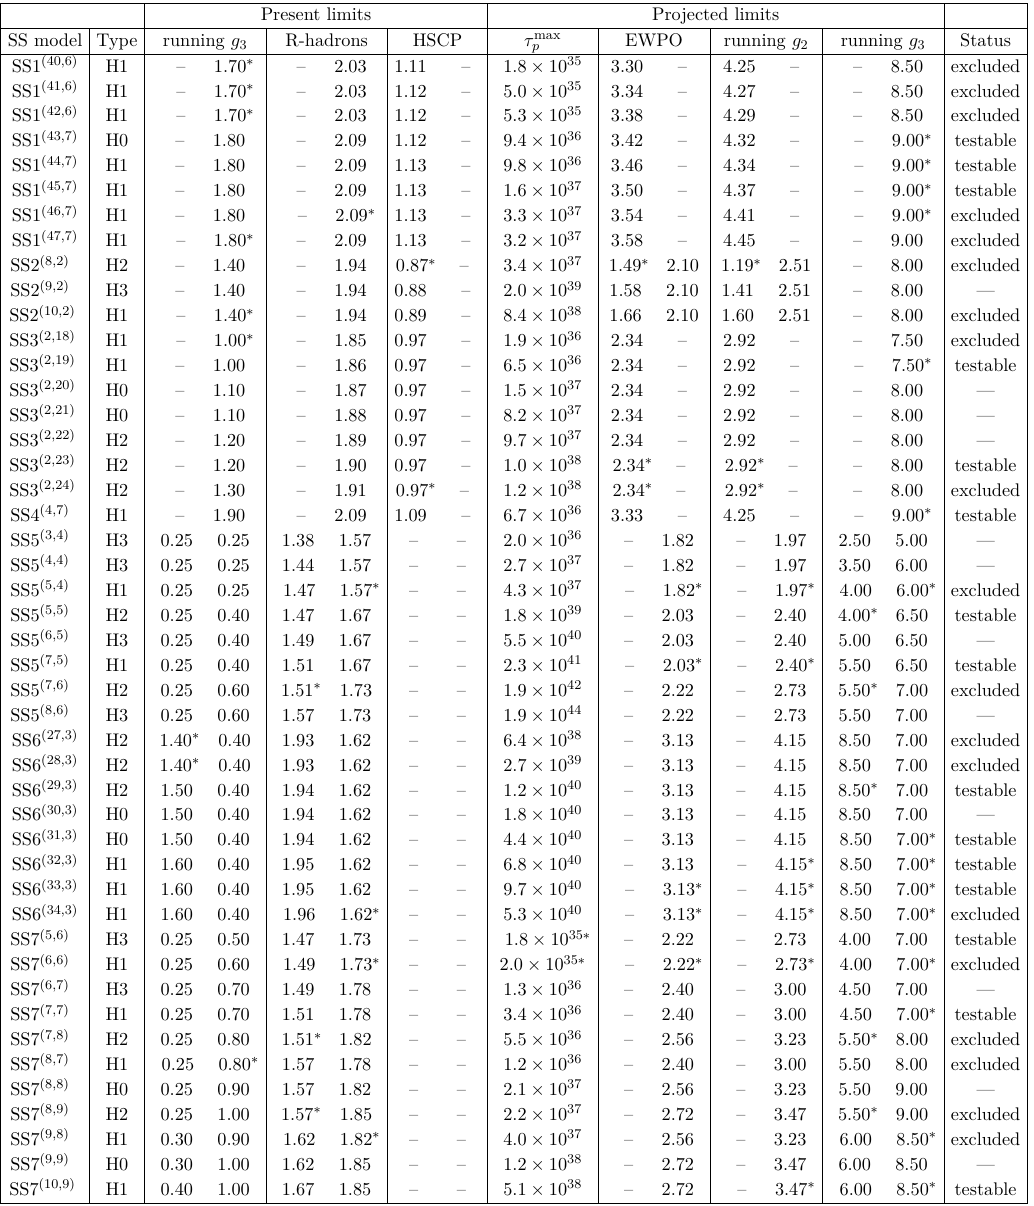
Table 7 . Scenarios with two different representations of scalars that allow for the PGU ( (cid:15) GUT ≤ 1% ) and the associated unification scale lies in the range 10 15 – 10 18 GeV . The scalar masses vary between 0.25 TeV and 10 TeV . In column 2 type of the model spectrum is given, as defined in eq. (2.12). In columns 3, 4 and 5 current lower bounds on the BSM masses (in TeV) are presented, as provided by the measurement of the running coupling g [37], R-hadrons [41] and charged HCSP [41] searches, 3 respectively. In column 6 the maximal proton lifetime (in years) is quoted in the PGU region of a given model. Projected sensitivities to the measurement of the running coupling g [42], the 2 EWPO [43] tests and determination of g [40] at the future 100 TeV collider are collected in columns 3 7, 8 and 9. Finally, in column 10 we indicate whether a given model is excluded by the current experimental limits, or if it will be entirely tested in the future. The experimental bound responsible for the exclusion (testability)of a model is indicated with an asterisk. ( Continued on the next page